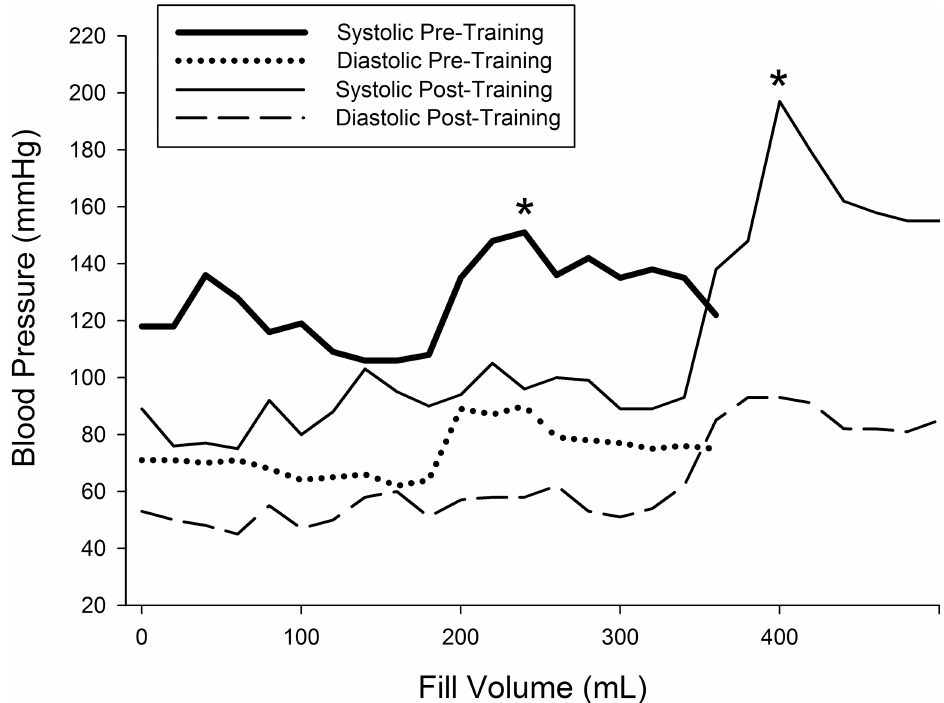
Fig 4. Blood pressure recording example during bladder filling. Blood pressure recordings for research participant C42 during filling pre- and post-training. Filling was stopped at the onset of autonomic dysreflexia (increase of > 20 mmHg), as indicated by the asterisk ( (cid:3) ). Note that the shift to a higher volume post-training is indicative of an increase in bladder capacity. Blood pressure returned to baseline by the time the bladder was emptied by catheterization for residual volume